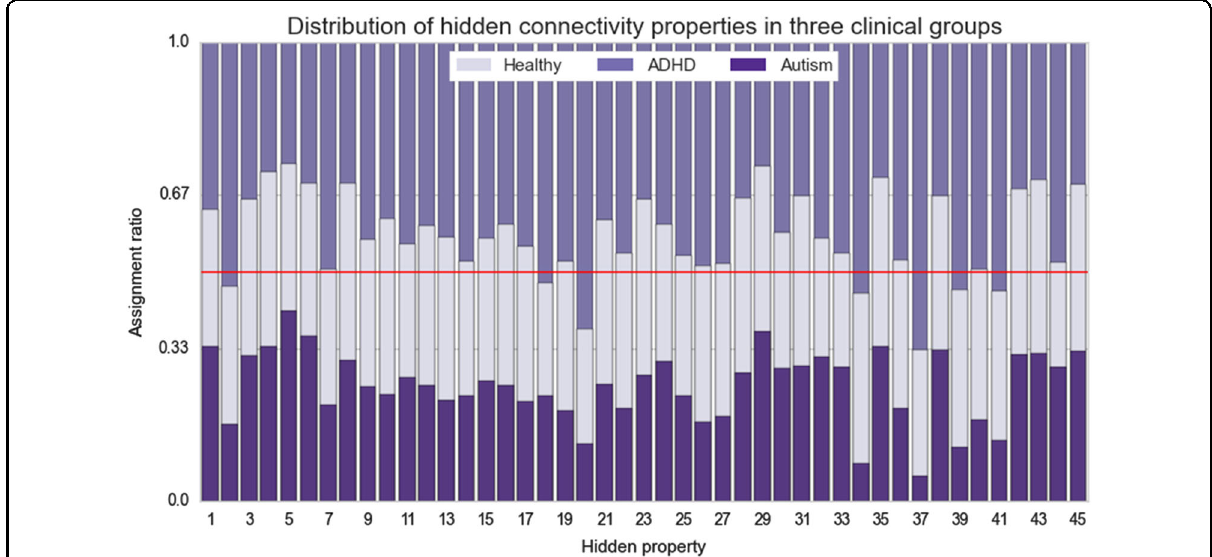
Fig. 3 Hidden properties in connectivity pro fi les. Healthy (middle section in the columns), ADHD (upper section in the columns), and ASD (lower section in the columns) participants are compared with regard to the relative occurrence of each distinct hidden component (columns). Each hidden property resulted directly from the Indian Buffet Process and is depicted here with its occurrence (present versus not present) added up across all participants. These were automatically discovered in the whole-brain connectivity pro fi les without knowing to which of the three groups each participant belonged. Visibly, the identi fi ed connectivity features are dispersed across the participant groups. No single connectivity feature was exclusively associated with only one